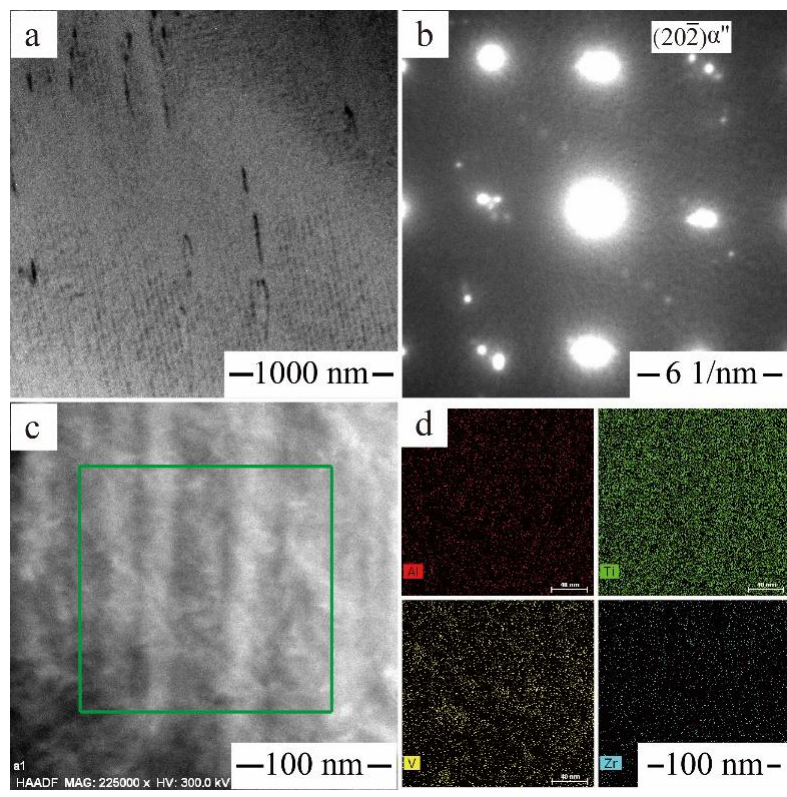
Figure 10. Microstructural feature of the Ti6Al4V30Zr alloy after beta annealing at 1050 °C: ( a ) bright field (BF) image showing α″ laths; ( b ) SAD (selected area electron diffraction) pattern with [113] β zone axis; ( c ) HAADF-STEM images; ( d ) The EDS mapping of Zr, V, Al, and Ti atoms.